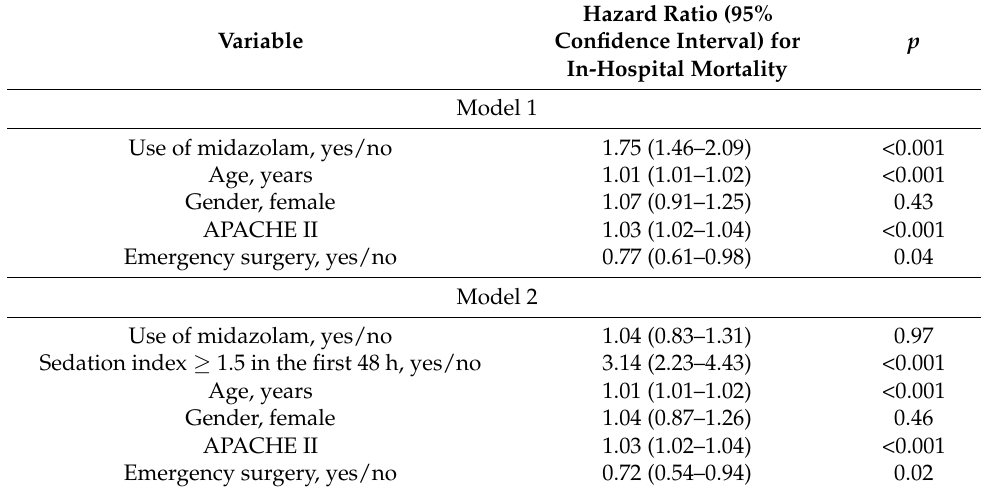
Table 6. Cox proportional hazards models for the in-hospital